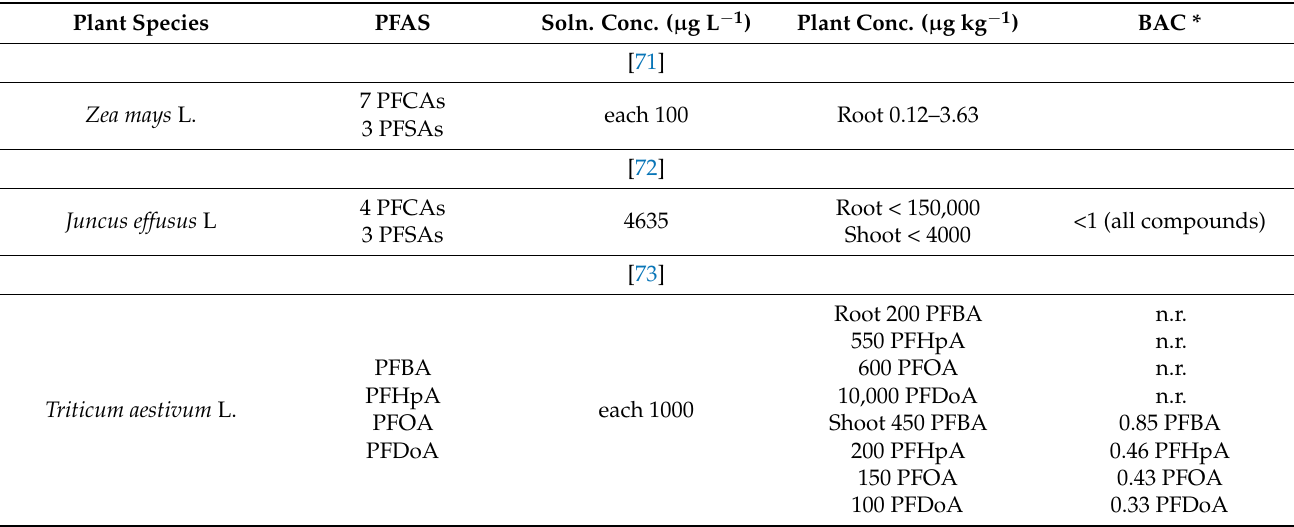
Table 2. Response of plants to PFAS compounds * in non-soil